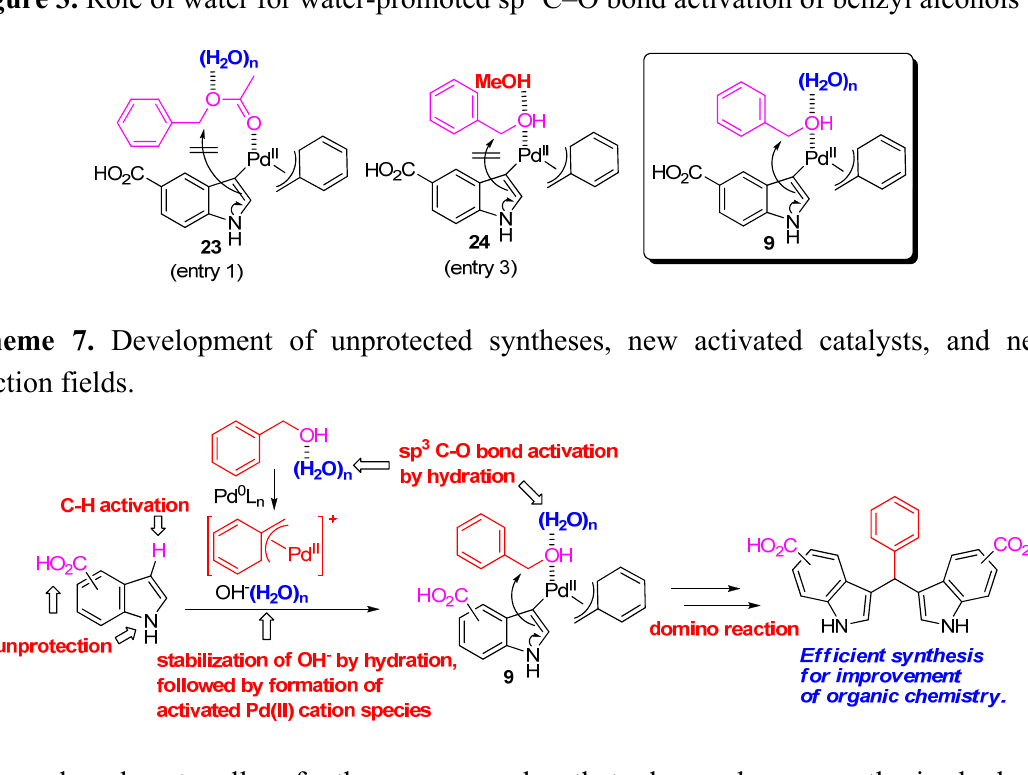
Figure 3. Role of water for water-promoted sp 3 C–O bond activation of benzyl alcohols 2 .